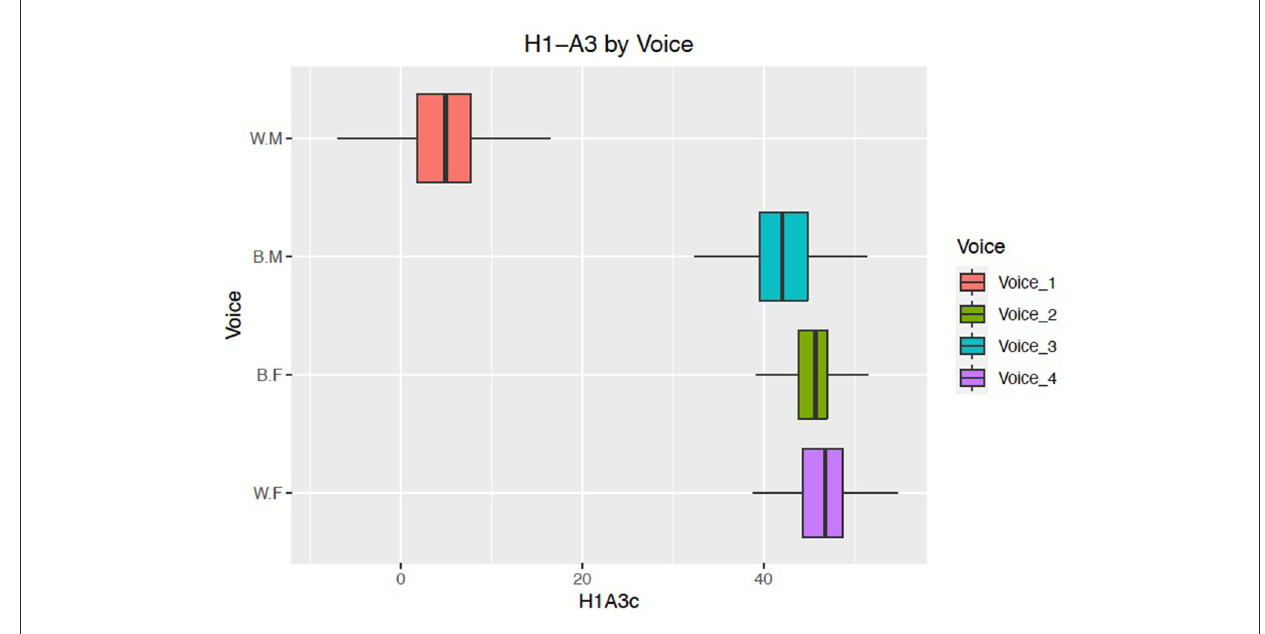
FIGURE8 Mean H1–A3 values by voice/race